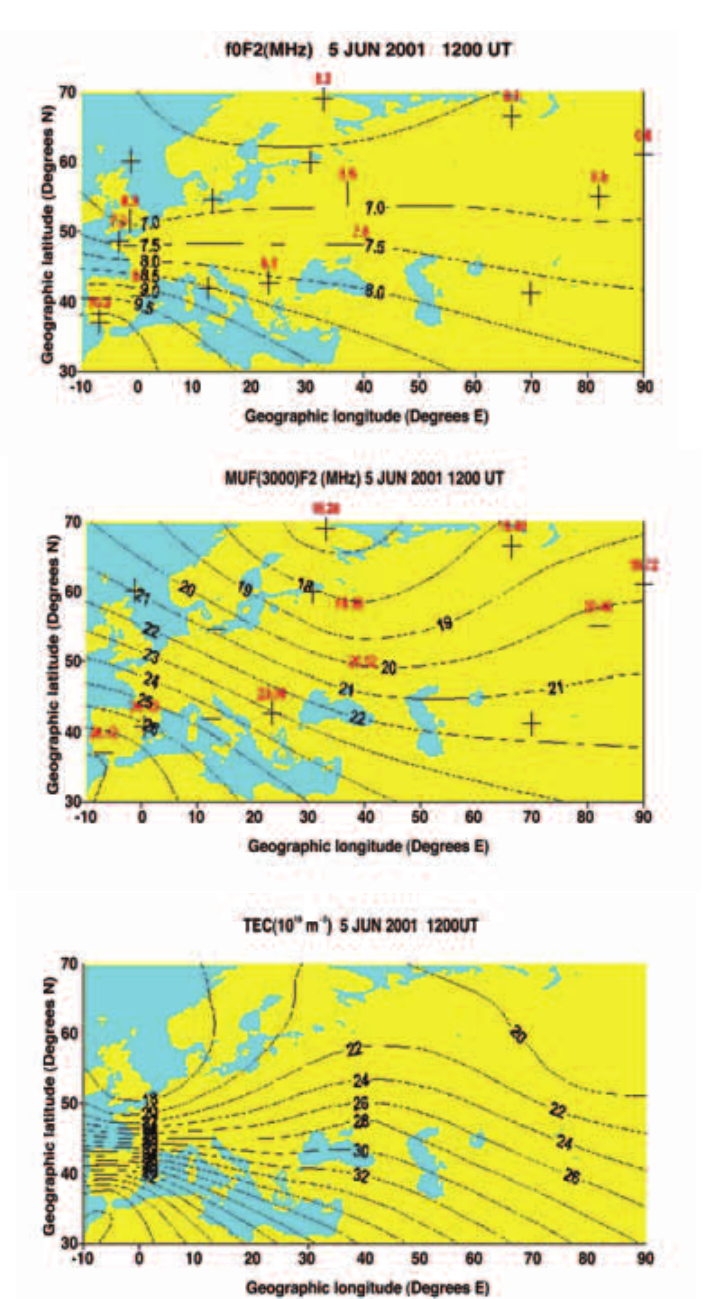
Fig. 2. Maps derived from measured values of foF 2, MUF(3000) F 2 and TEC for 5 June 2001 at 1200 UT